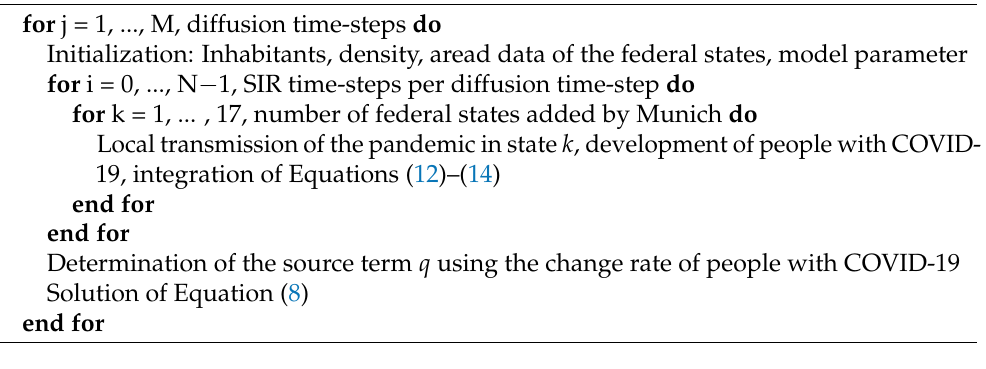
Algorithm 1 Diffusion model coupled with the SIR-model.